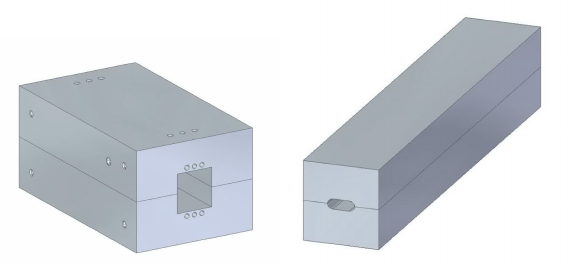
Figure 6: Sample models of the designed calibrator after the de- posit of the upper and bottom parts, and a calibration insert for the production of electric cable